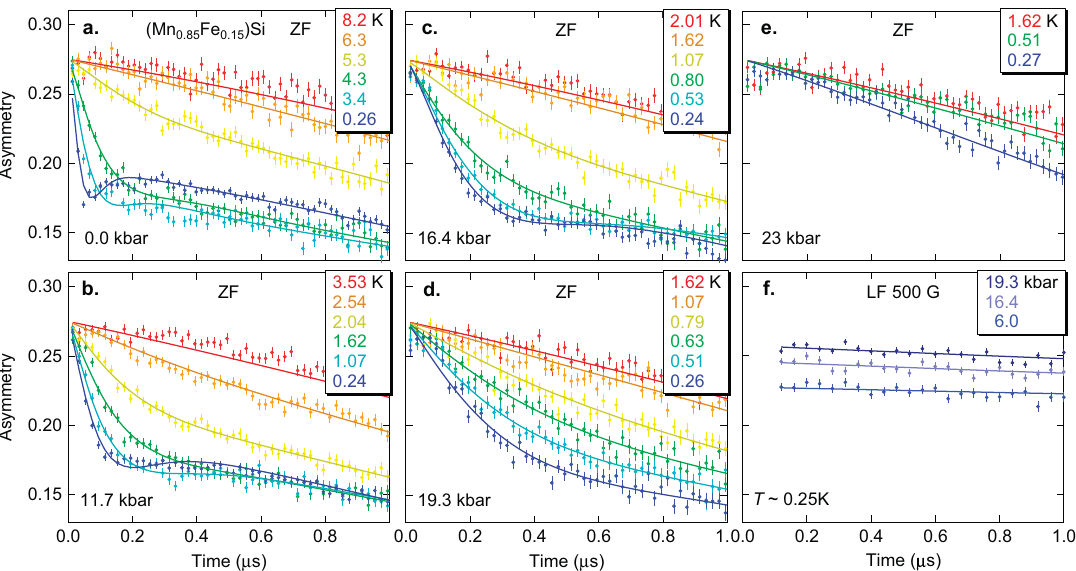
Fig. 2 MuSR time spectra observed in a single crystal specimen of (Mn 0.85 Fe 0.15 )Si. a – e Results in zero fi eld at hydrostatic pressures p = 0.0, 11.7, 16.4, 19.3 and 23.0 kbar. f Results with a longitudinal fi eld (LF) of 500 G applied parallel to the initial spin direction of the incident positive muons. The lines represent fi ts to the relaxation functions given by Eqs. (1) – (4) in the main text. More details can be found in the Supplementary Information. Panel e shows that static magnetic order disappears at p = 23 kbar, and that the effect of the pressure cell on the observed spectra is minimal. Panel f demonstrates that the fast relaxation seen at low temperature is due to static random local fi elds, which can be decoupled by the application of